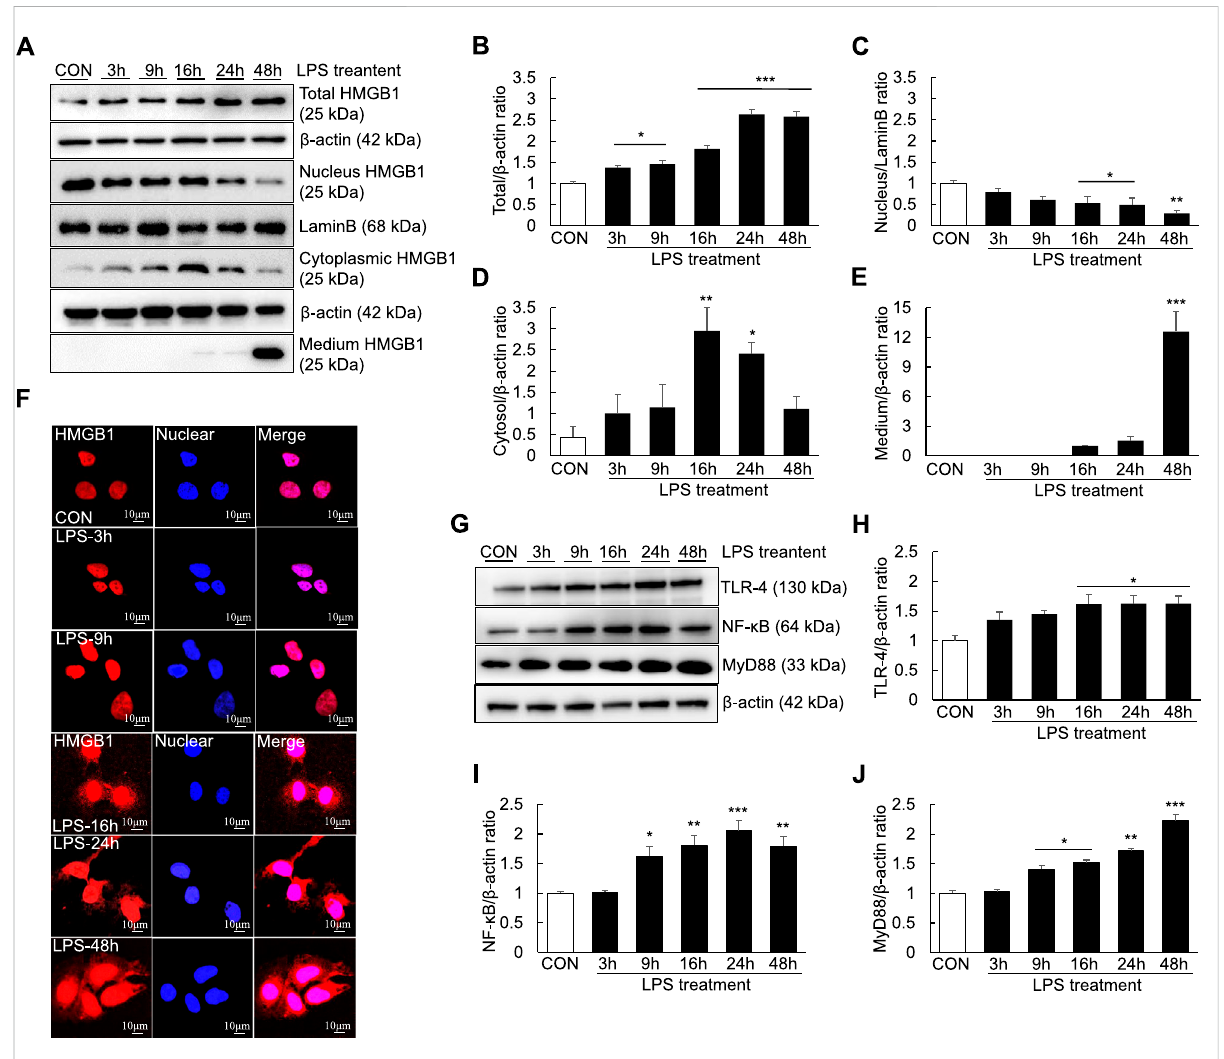
FIGURE 6 Extracellular releaseofHMGB1 andTLR-4/NF- κ Bsignaling inLPS-inducedHuh7cells.Huh7cellsweretreatedwith1000 ng/mlLPSfor3,9,16, 24, and 48 h. Western blotting was performed to determine the total, nuclear and cytoplasmic levels of HMGB1 (A – D) as well as the extracellular levels of HMGB1 (in the medium) (A,E) . Confocal microscopy was performed using anti-HMGB1 antibody and DAPI (F) and HMGB1-positive cells were identi fi ed using an anti-rhodamine-conjugated antibody. We also examined TLR-4,NF- κ B, and MyD88 expression via western blotting (G – J) . * p < 0.05, ** p < 0.01, *** p < 0.001 vs.